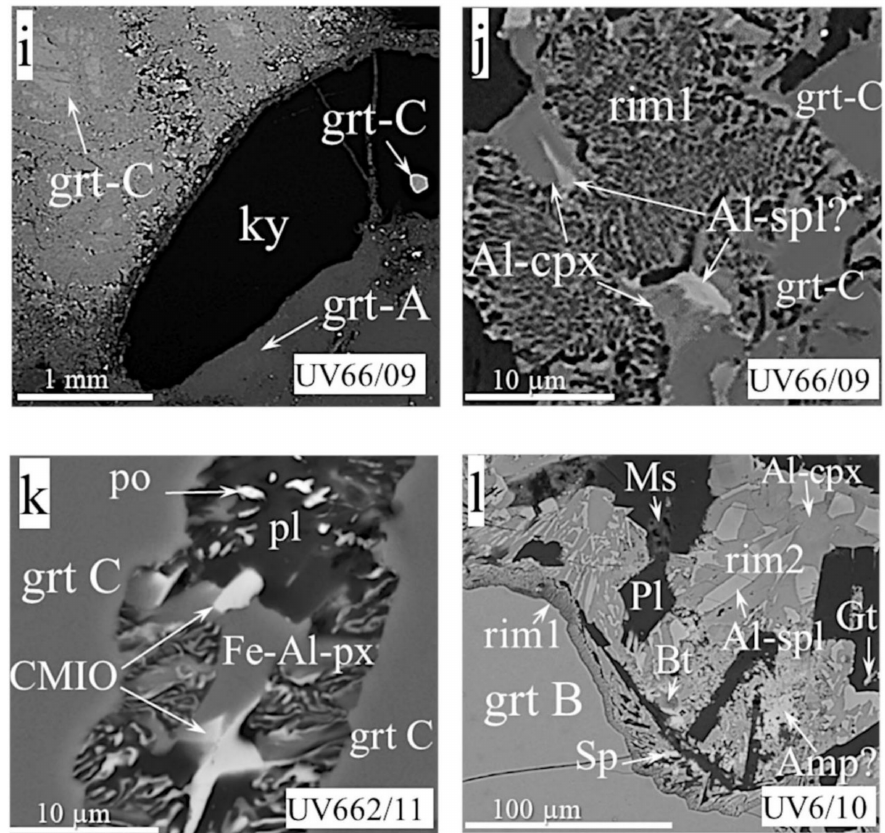
Figure 4. BSE images of the kelyphitic rims on garnets from Ecl A, B, C: ( a ) Rim1 developing in a crack of Ecl A garnet from di-amondiferous eclogite; ( b ) enlarged rim2 minerals; ( c ) strongly elongated symplectites of rim1 on Ecl A garnet; ( d ) rim1 (narrow strip of symplectites surrounding the garnet) and rim2 (large grains of Al-opx, Al-cpx, Al-spl); ( e ) rim1 on Ecl B garnet, separated from rim2 by a strip of plagioclase; ( f ) symplectites of the rim1 surrounding several grains of Ecl B garnet; ( g ) very thin symplectites of zoned rim1 on the Ecl B garnet; ( h ) zoned rim3 on Ecl A garnet; ( i ) Ecl A and C garnets in kyanite eclogite UV66/09; ( j ) rim1 surrounding several grains of Ecl C garnet; ( k ) rim1 in a crack of group C garnet; ( l ) rim1 (narrow strip around the group C garnet) and complex unstructured